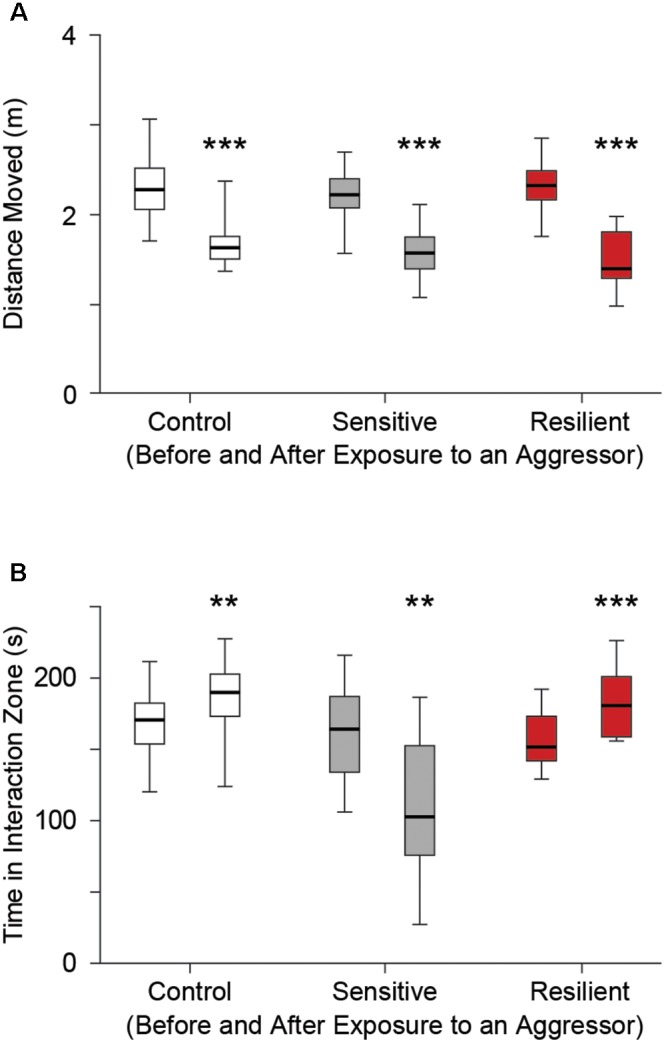
Social interaction test. (A) Distance moved for each group before (left box whisker) and after (right box whisker) placement of a novel aggressor mouse (retired CD-1 breeder) in the control, stress sensitive, and stress resilient groups. There was a significant reduction in distance moved in all three groups after placement of an aggressor compared to when an aggressor wasn’t present (∗∗∗p < 0.001, Two way ANOVA, n = 28, 16, 12 for the control, stress sensitive, and stress resilient groups respectively). The similar reduction in distance moved for all groups establishes that differences in social interaction in (B) are not due to differences in mobility. (B) Time spent in the interaction zone before and after placement of a novel aggressor. Both control and stress resilient mice showed a significant increase in time spent in the interaction zone after placement of the aggressor. Stress sensitive mice showed a significant reduction in the time spent in the interaction zone after placement of a novel aggressor compared to when the aggressor was not present. This shows the effect of social defeat on the stress sensitive mice compared to their control or resilient counterparts (∗∗p < 0.01, ∗∗∗p < 0.001, Paired student’s t-test with Bonferroni correction, n = 28, 16, 12 for the control, stress sensitive and stress resilient groups respectively).